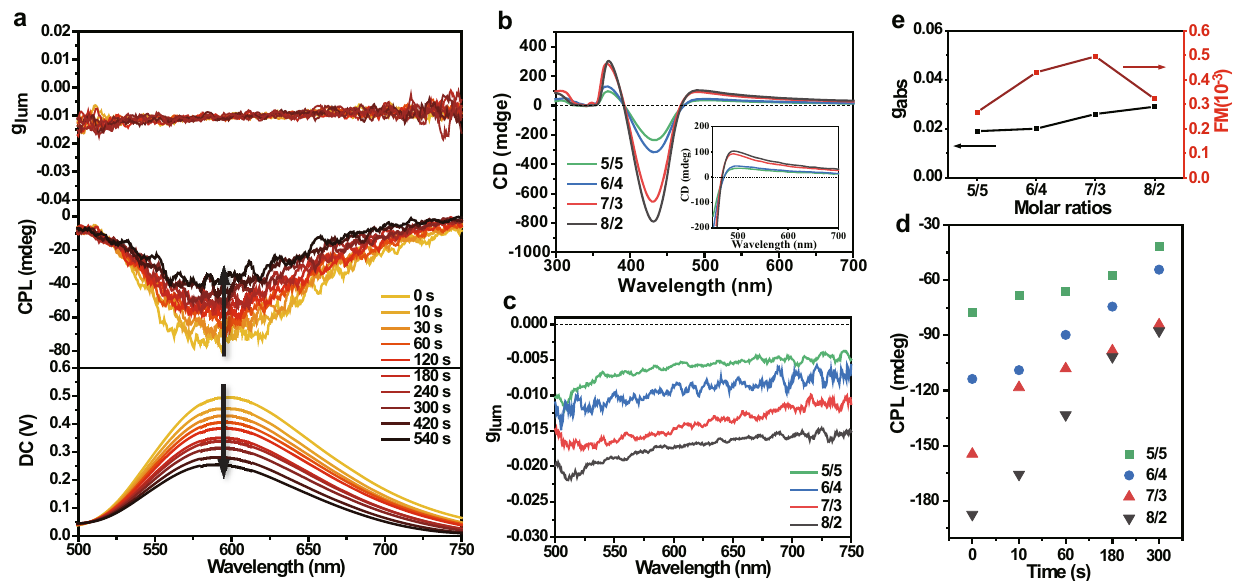
Fig. 3 | The chiro-optical properties. a The CPL of p( R- phNA 7 BrNpA 3 )-PMMA fi lm duringfade-awayprocess( λ ex =365nm). b TheCDspectraofp( R -phNA-co-BrNpA)- PMMA fi lm withdifferentcopolymerizationmolar ratios. c Theg lum spectraof p( R - phNA-co-BrNpA)-PMMA fi lm with different copolymerization molar ratios.